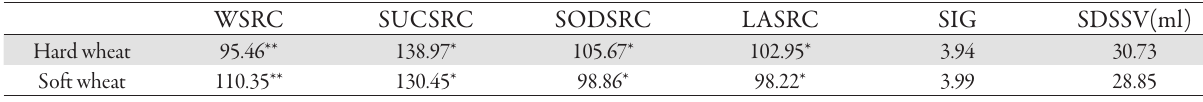
Tab. 2. Flour quality parameters of the soft and hard wheat